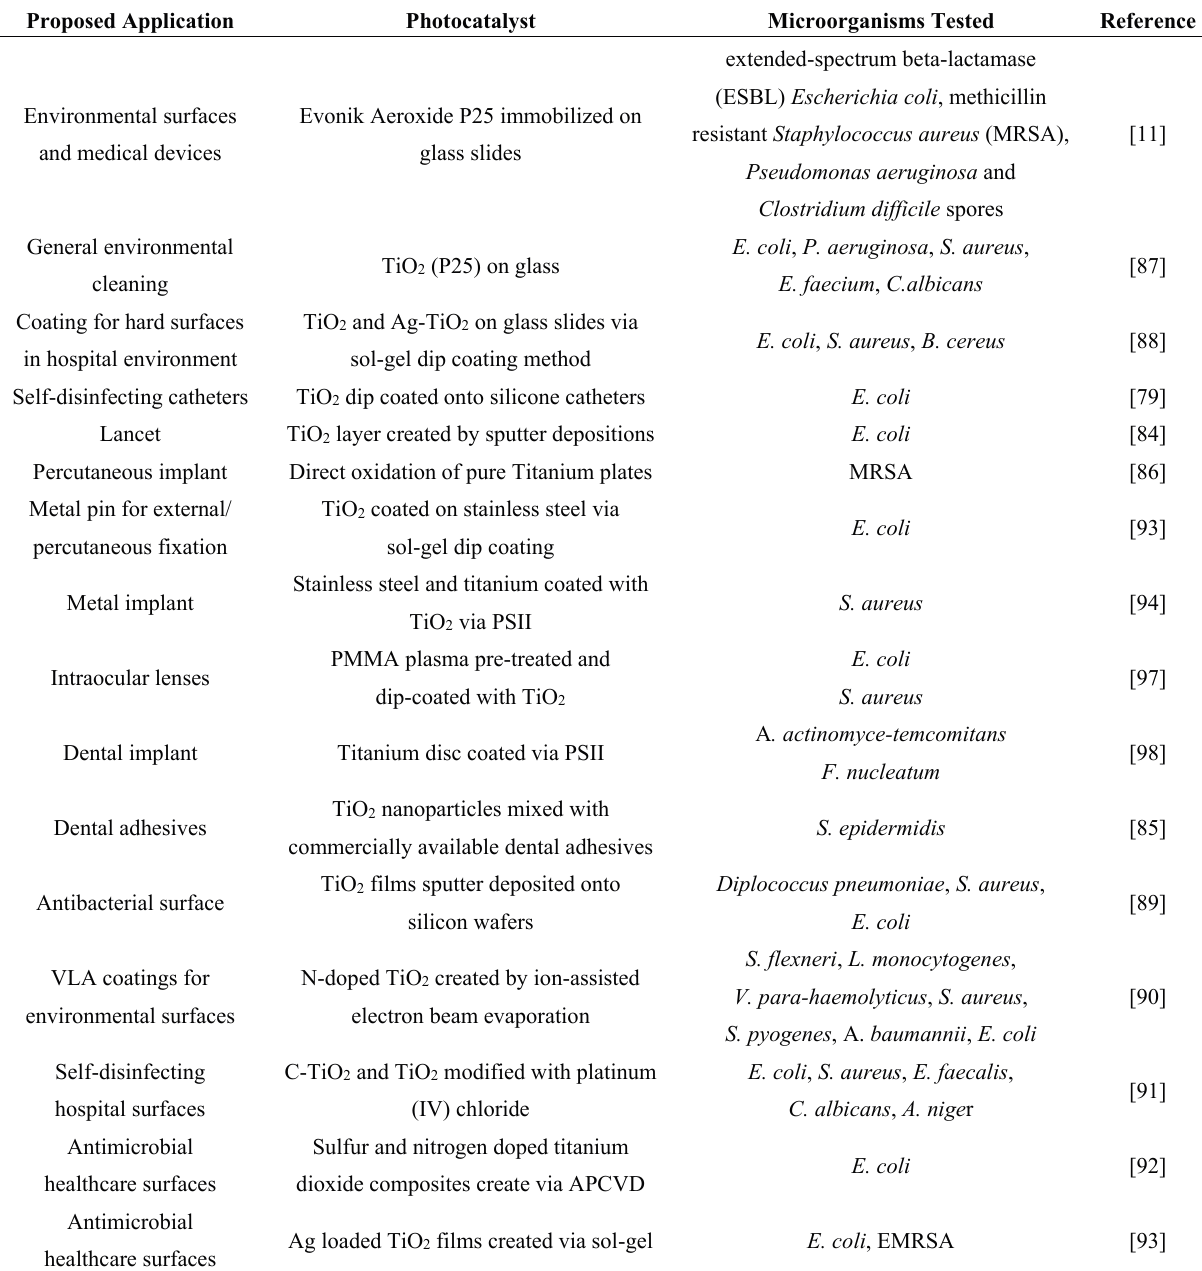
Table 1. Showing application, type of photocatalyst, microorganism tested and